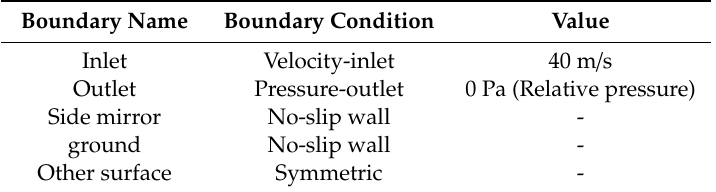
Table 2. Settings of boundary conditions.